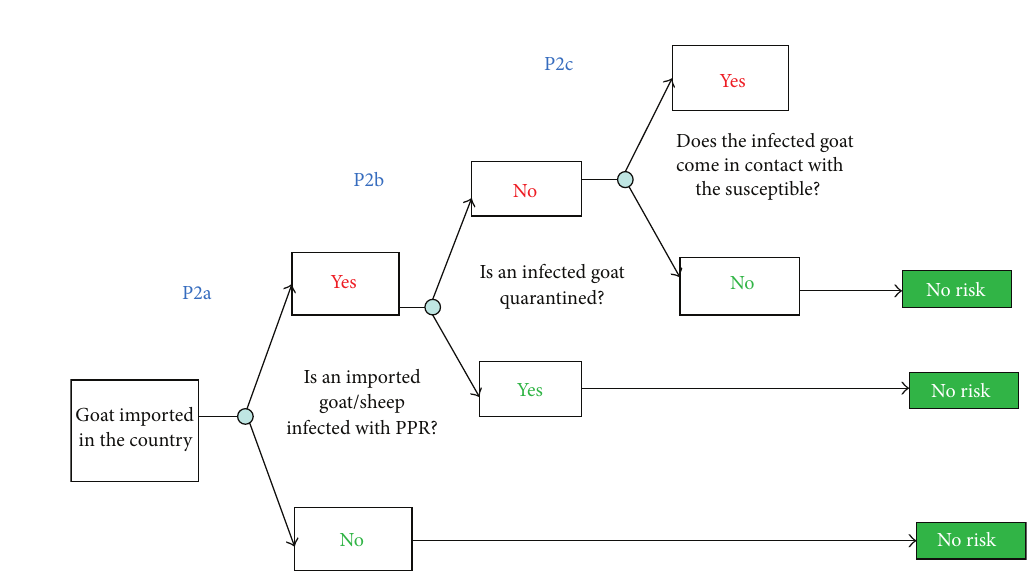
Figure 3: Scenario tree for PPR consequence of release, exposure, and infection.